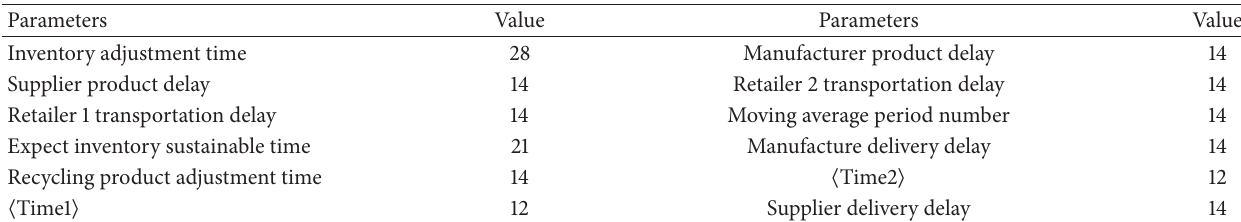
Table 1: Model constants